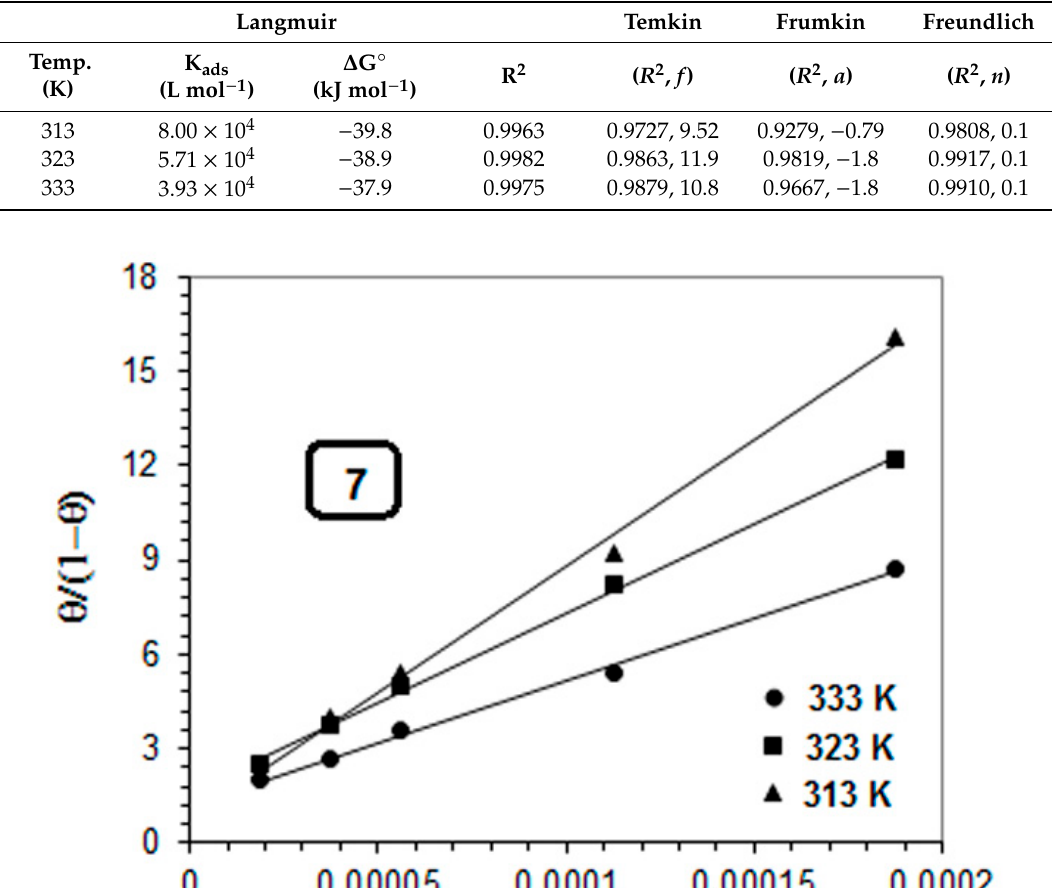
Table 4. Adsorption parameters for corrosion inhibitor 7 calculated from Langmuir adsorption isotherm, and the square correlation coe ffi cient (R 2 ) and constant values in di ff erent adsorption isotherms for mild steel in 1 M HCl solution at di ff erent temperatures. Langmuir Temkin Frumkin Freundlich